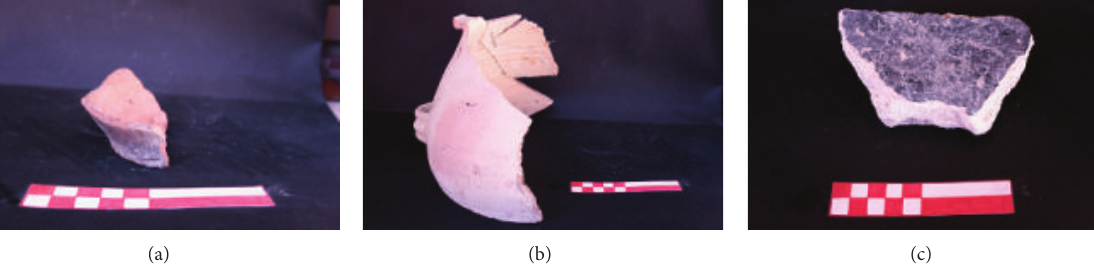
Figure 3: Images of the samples VII59B11 (a), VI59B7Z (b), and 659A14730 (c).